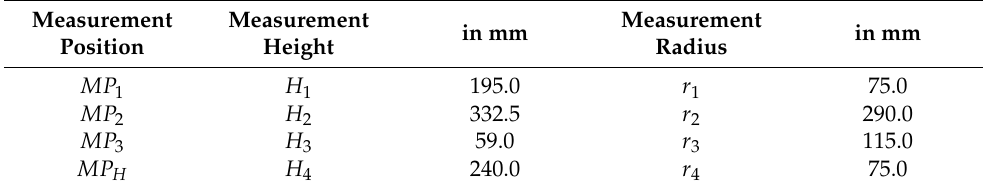
Table 1. Dimensions of the measurement positions measured from the top edge of the suction orifice to the middle of the measurement position.